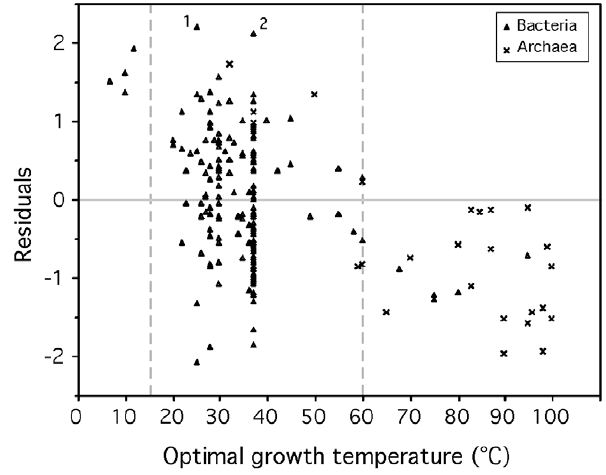
Figure 4. Correlation between the residuals of the model (eq. 1) and optimal growth temperature (OGT). Sperman correlation r = 2 0.37, p-value , 0.0001. Residuals are positive for psychrophiles (OGT , 15 u C) and negative for thermophiles (OGT . 60 u C), indicating that for the former (latter) the observed minimal generation time is lower (higher) than expected from the genomic signatures. Relevant